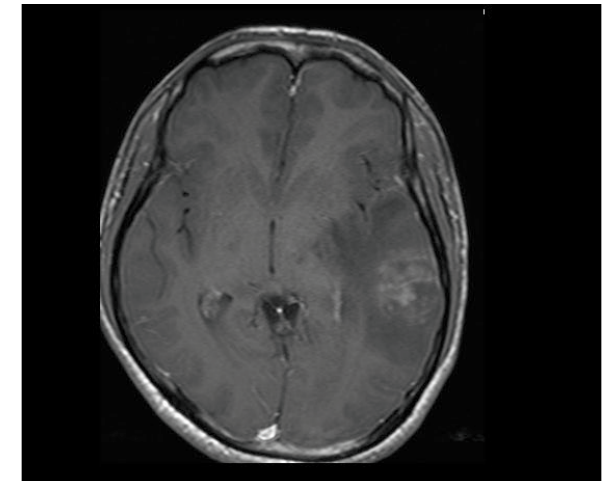
intense perilesional oedema, compression of the ipsilateral lateral ventricle, effacement of surrounding sulci, and a noticeable shift of the midline to the right.